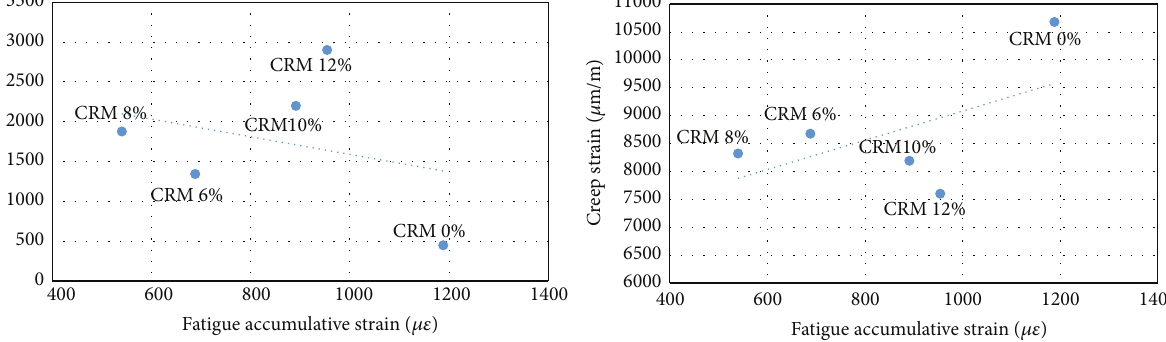
Figure 5: Fatigue versus stiffness and creep at 200 kPa